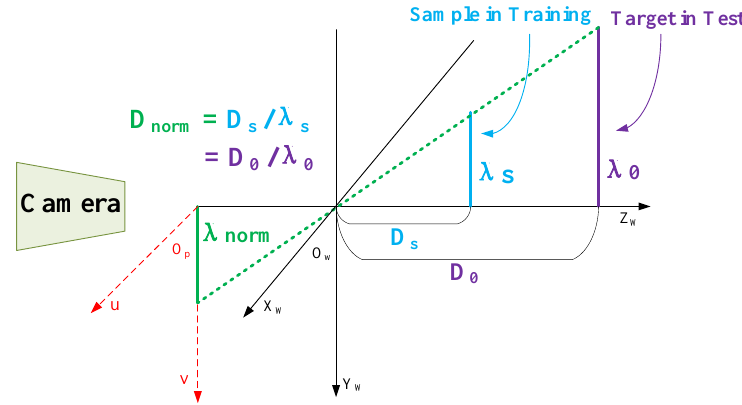
Figure 6. Schematic diagram of the normalized depth value.